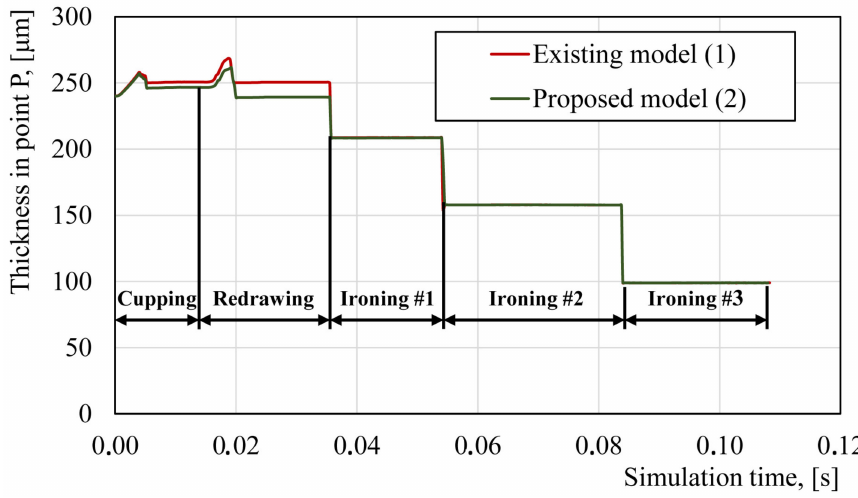
Figure 13. Comparison of the thickness value at point P for the existing flow stress model (1) and the developed model (2). Table 6. Comparison of the thickness of the beverage can wall at material point P for the numerical models and measurement. Numerical Models and